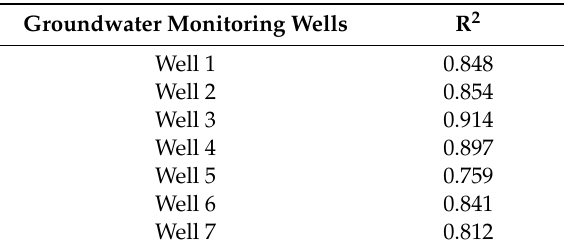
Table 3. MLP model